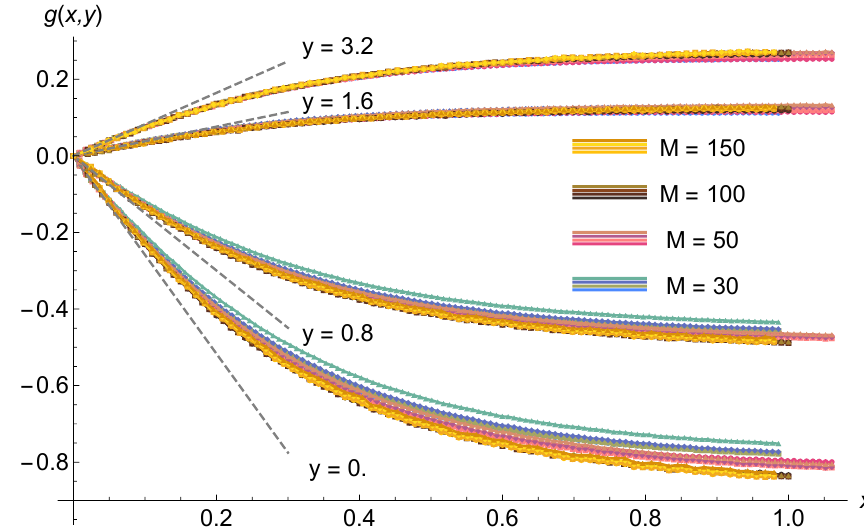
Figure 8: Plot of the same data as in figure 5, showing differences between scaled smoothed curvature correlation function g ( x , y ) at different points, and the correla- tion function g ( 0, y ) at the same point, as a function of x for several fixed values of y . Straight dashed lines show the small- x asymptotic (75) of g ( x , y ) for the corre- sponding y , and also serve to label the data sets. Compared to figure 5 the curves exhibits significantly better data collapse, and good agreement with the slopes of the dashed